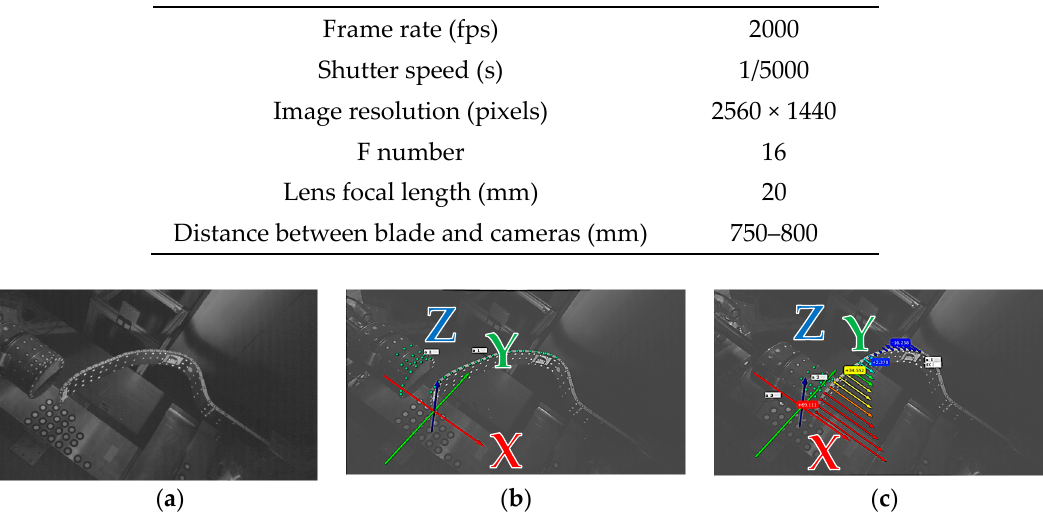
Figure 3. Examples of typical high-speed images: ( a ) high-speed image before impact; ( b ) tracking image before impact; ( c ) tracking image at the phase of the maximum deformation of the blade. The x and z axes are defined as the direction parallel and vertical to the incidence direction of the impactor, respectively. Green dots and arrows represent tracked markers and the displacement of markers, respectively. The length and direction of the arrow expresses the magnitude and direction of the displacement,